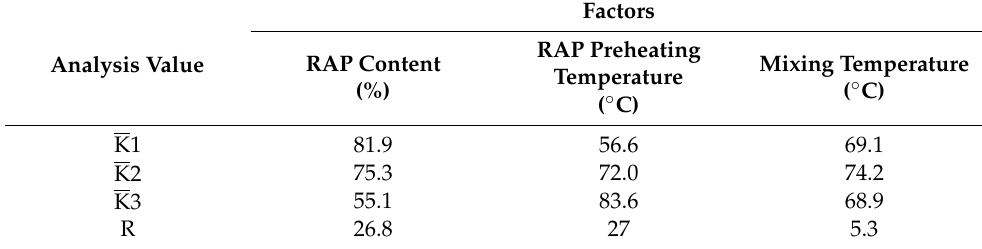
Table 6. Range analysis